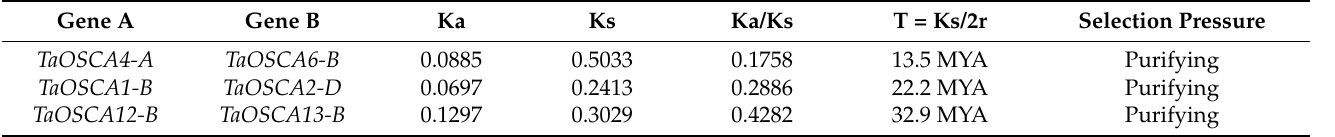
Table 1. The Ka/Ks ratios and divergence times of duplicated TaOSCA gene pairs.